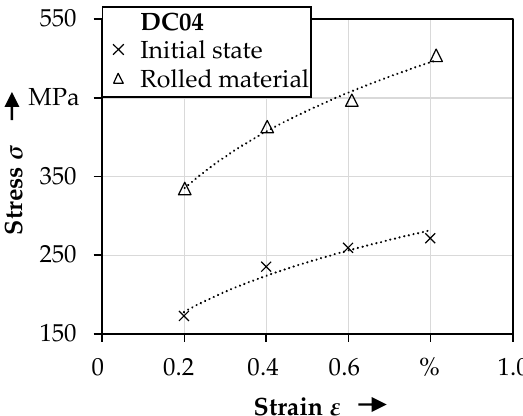
Figure 13. Cyclic stress–strain curves determined for the initial and rolled material state, compiled from [5].